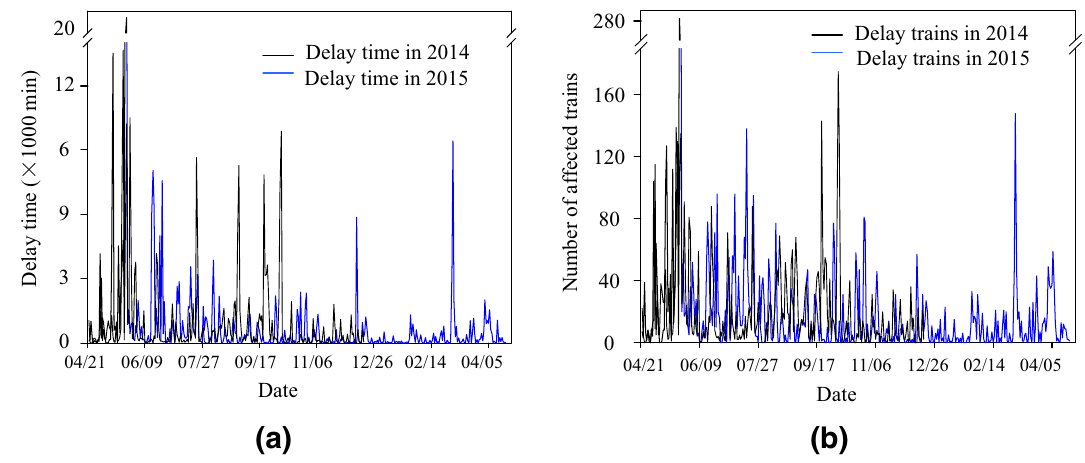
Fig. 3 Total delay time ( a ) and the number of delayed trains ( b ) on individual